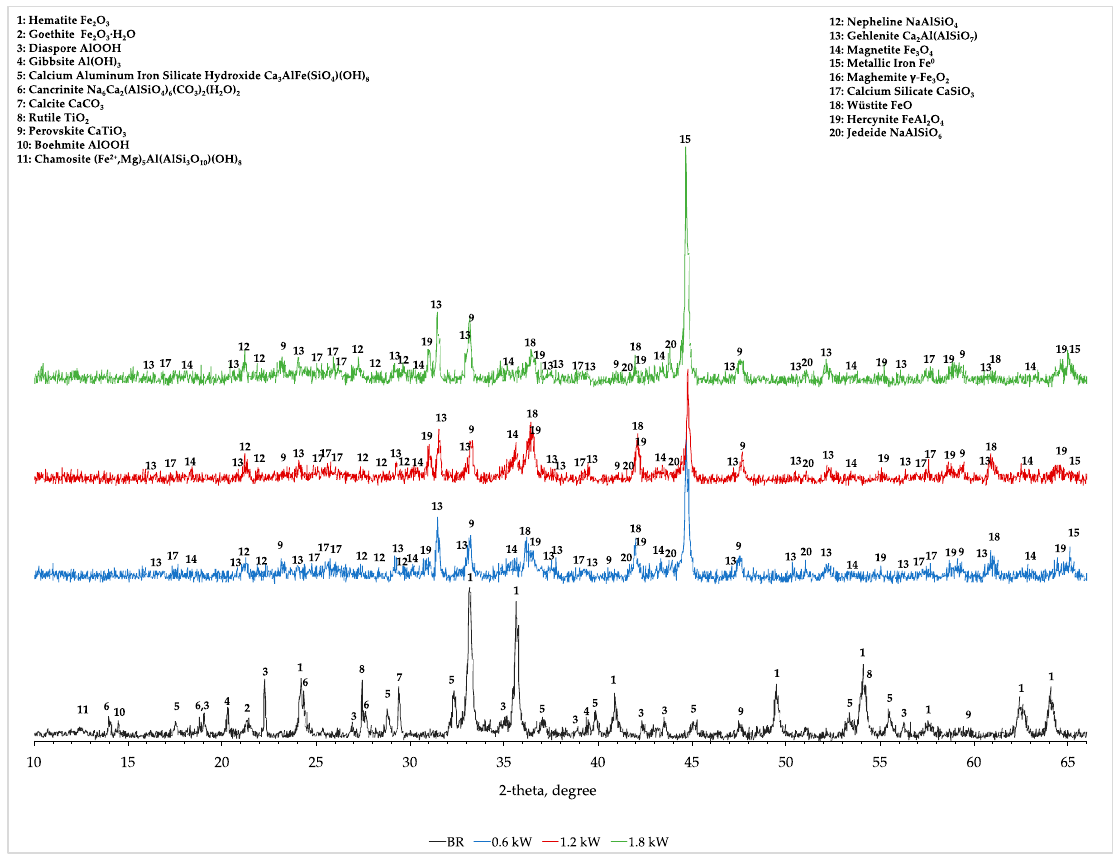
Figure 4. XRD of sinters (C / BR 0.180, and 1 L / min N 2 flow constant for 5 min) by changing the amount of microwave (MW) energy (0.6 kW, 1.2 kW, and 1.8 kW) and compared with XRD of bauxite residue.